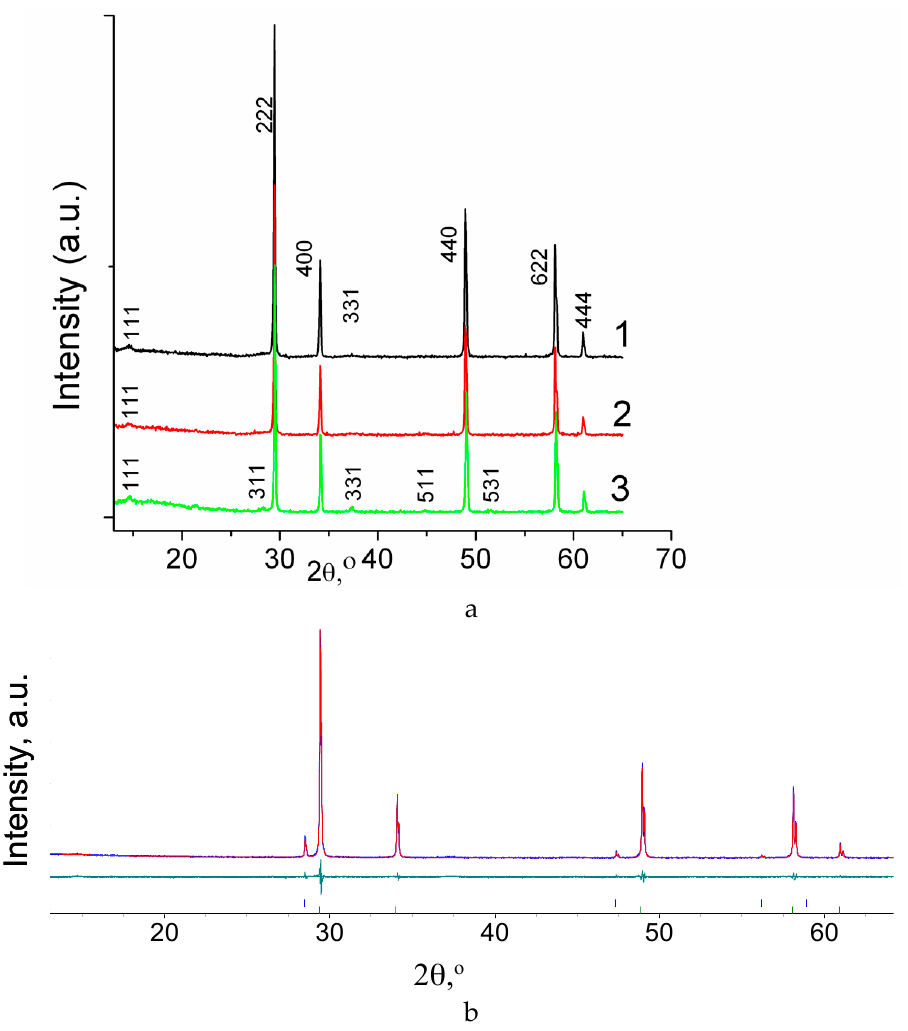
b Figure 2. ( a ) XRD patterns of the Gd 2 − x Ca x Zr 2 O 7 − x / 2 (1) x = 0.05, (2) x = 0.1, and (3) Gd 1.9 Mg 0.1 Zr 2 O 6.95 ; Figure 2. ( a ) XRD patterns of the Gd 2 − x Ca x Zr 2 O 7 − x/2 (1) x = 0.05, (2) x= 0.1, and (3) ( b ) Rietveld data of Gd 2 − x Ca x Zr 2 O 7 − x / 2 (x = 0.05) XRD pattern: the measured (blue line), the calculated Gd 1.9 Mg 0.1 Zr 2 O 6.95 ; ( b ) Rietveld data of Gd 2 − x Ca x Zr 2 O 7 − x/2 (x = 0.05) XRD pattern: the measured (blue line), the calculated (red line), the difference between measured and (red line), the di ff erence between measured and calculated data (green line). Vertical bars show calculated data (green line). Vertical bars show calculated reflections for different phases calculated reflections for di ff erent phases Gd 1.95 Ca 0.05 Zr 2 O 6.975 (lower) and Si internal standard (upper). Gd 1.95 Ca 0.05 Zr 2 O 6.975 (lower) and Si internal standard (upper). R wp = 2.92%, R p = 3.67%, R exp = R wp = 2.92%, R p = 3.67%, R exp = 2.82%, GOF = 2.82%, GOF = 1.26.